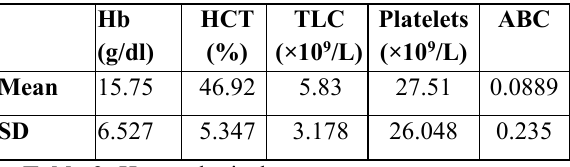
Table-2: Hematological parameters Hb: hemoglobin, HCT: hematocrit, TLC: total